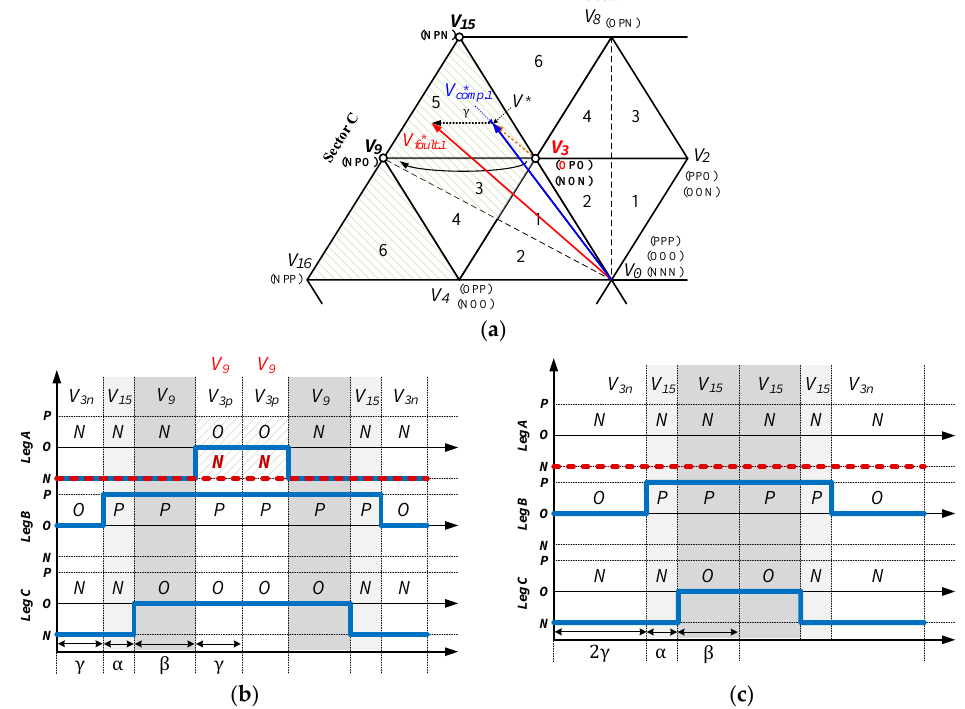
Figure 8. Reference voltage and switching patterns under the fault case 1. ( a ) Distortion and compensation of the reference voltage; ( b ) Switching pattern under the fault condition; ( c ) Switching pattern with the proposed fault-tolerant control